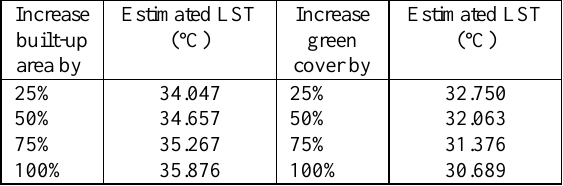
Table 6. Estimated LST value if both parameters are increased by 25%, 50%, 75% and 100% of the current built-up area and green cover values in Bukit